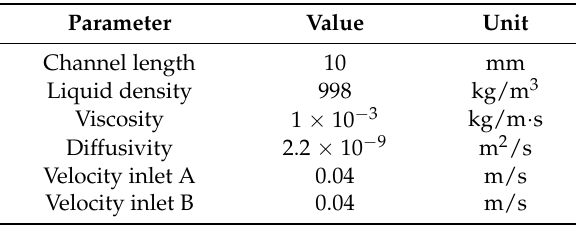
Table 2. Physical and geometrical